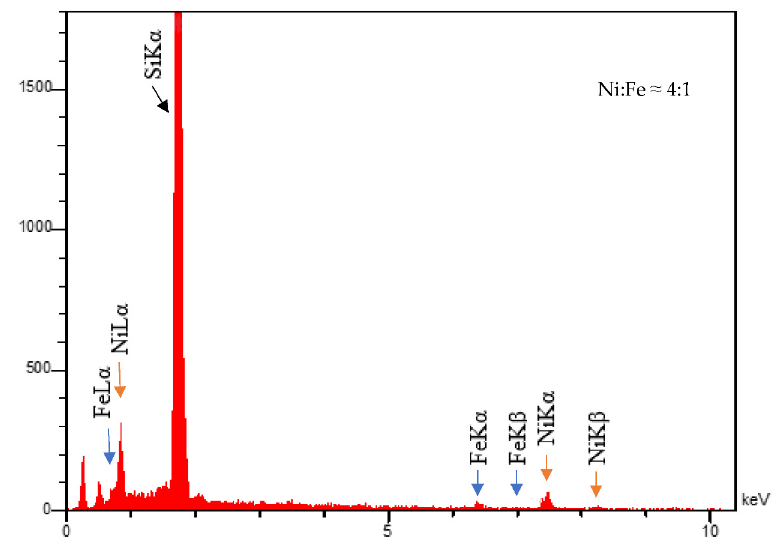
Figure 2. EDS analysis of sample S1.